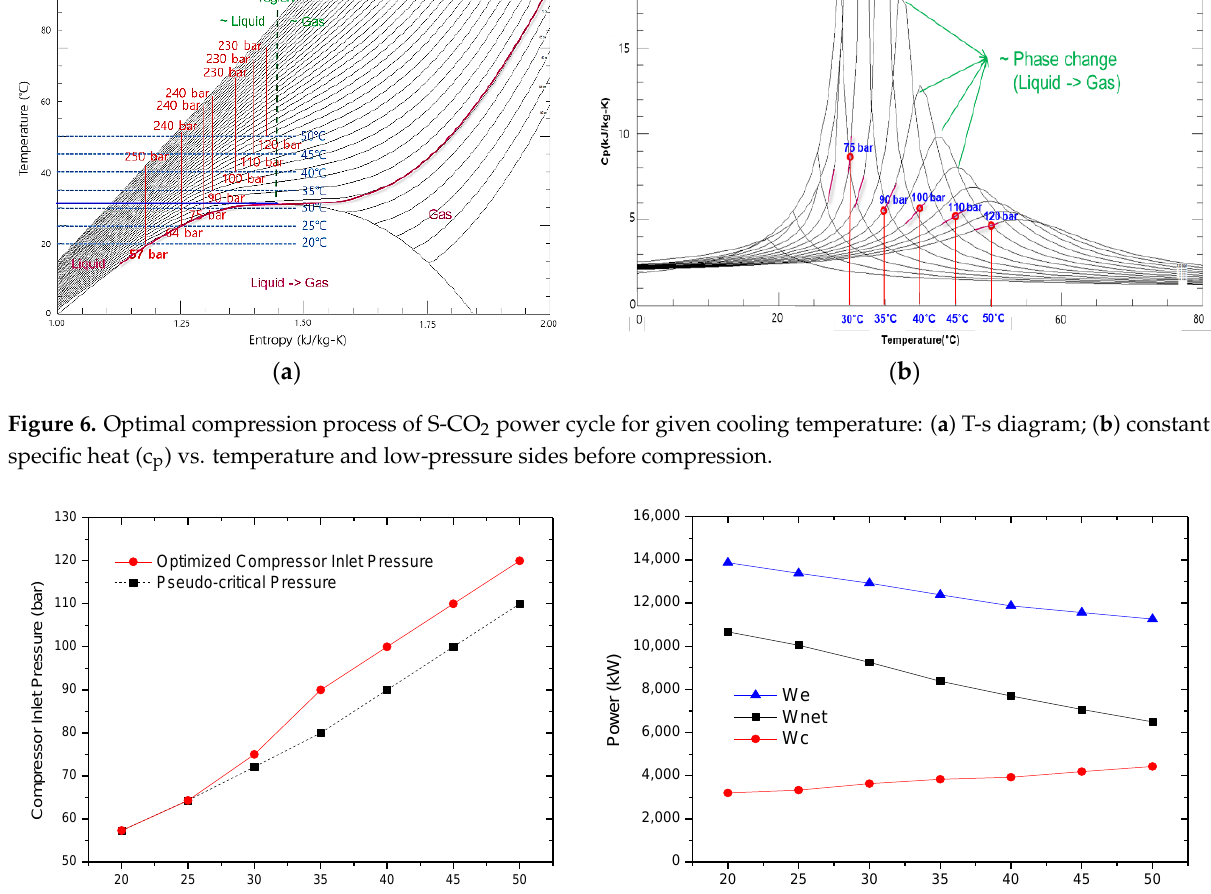
( b ) Figure 8. Optimal operating condition of S-CO 2 power cycle for given exhaust gas temperature from engine: ( a ) Low- pressure (LP) and high-pressure (HP) sides; ( b ) turbine inlet temperature. Figure 9 shows the maximum system efficiency and net power of the WHR split S- CO 2 cycle with an increase in the heat source temperature. As the heat source temperature increases in steps of 50 °C from 300 to 400 °C, the system efficiency increased by approxi- mately 2% (absolute efficiency), and the net power significantly increased by 30 to 40%.